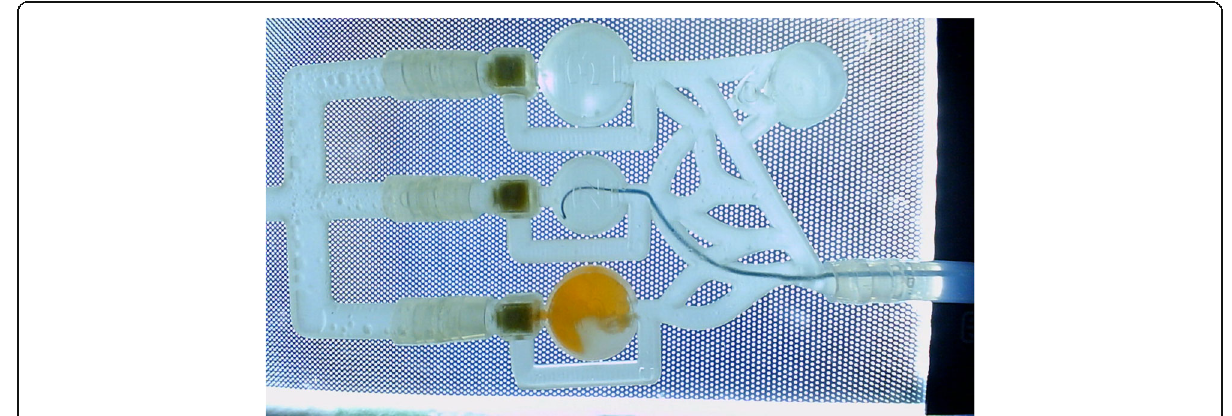
Fig. 4 View of the model displayed on the laptop screen during the